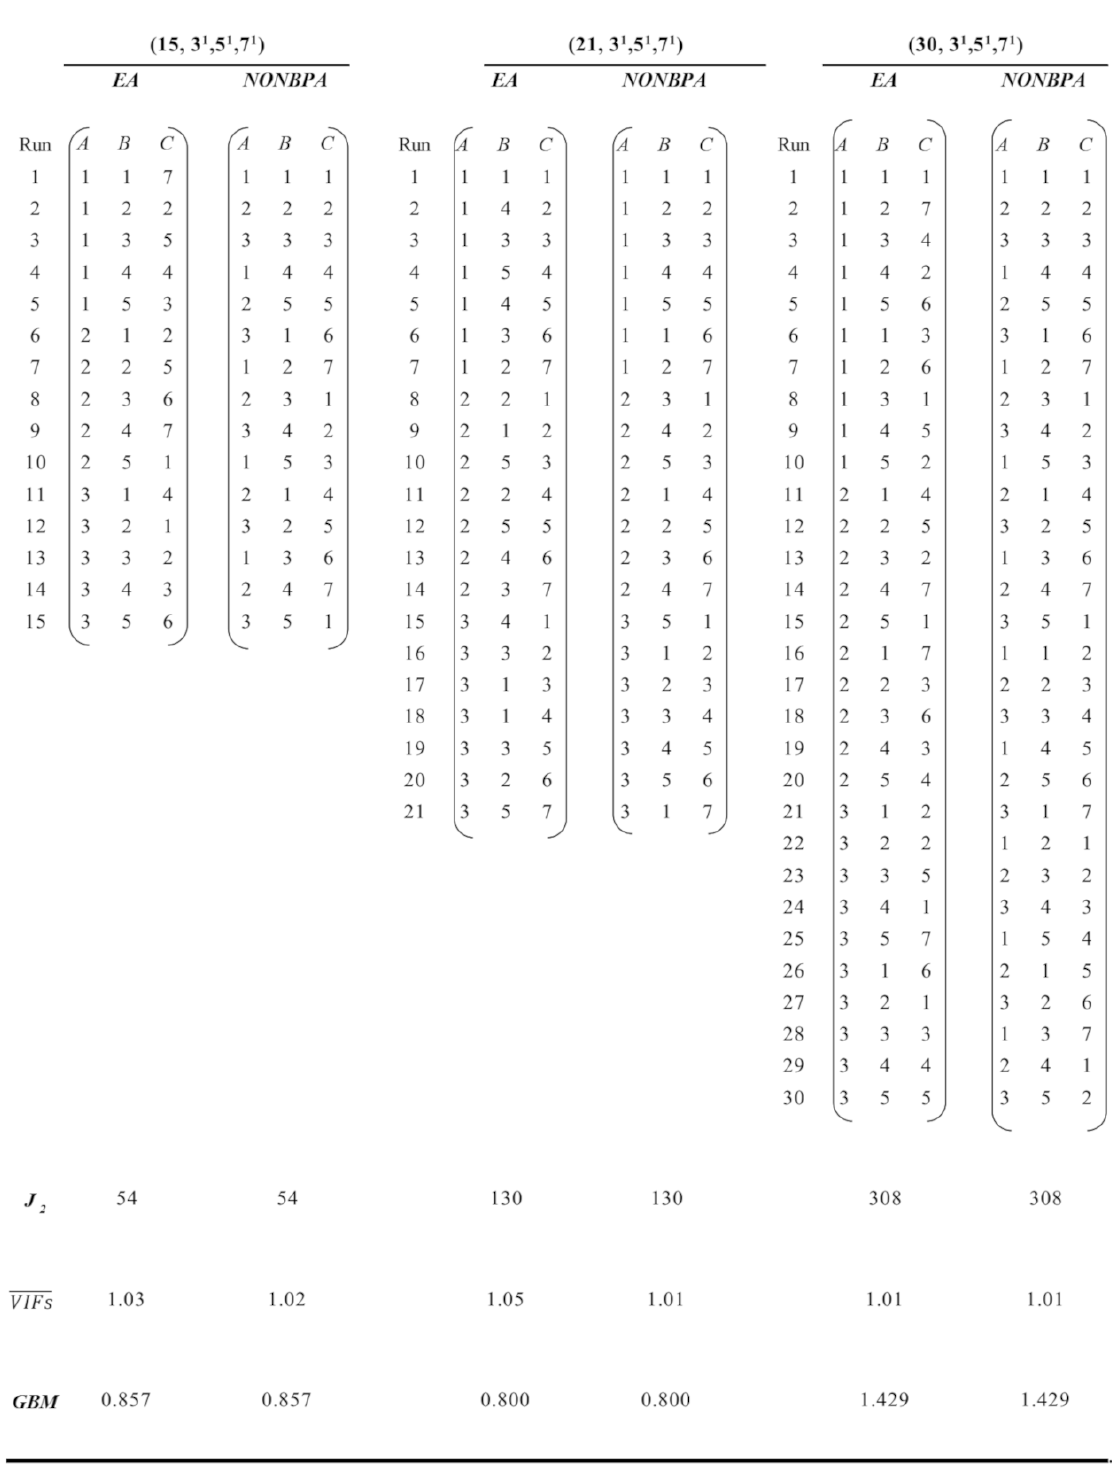
Figure 10. Comparison of EA vs. NONBPA using different run